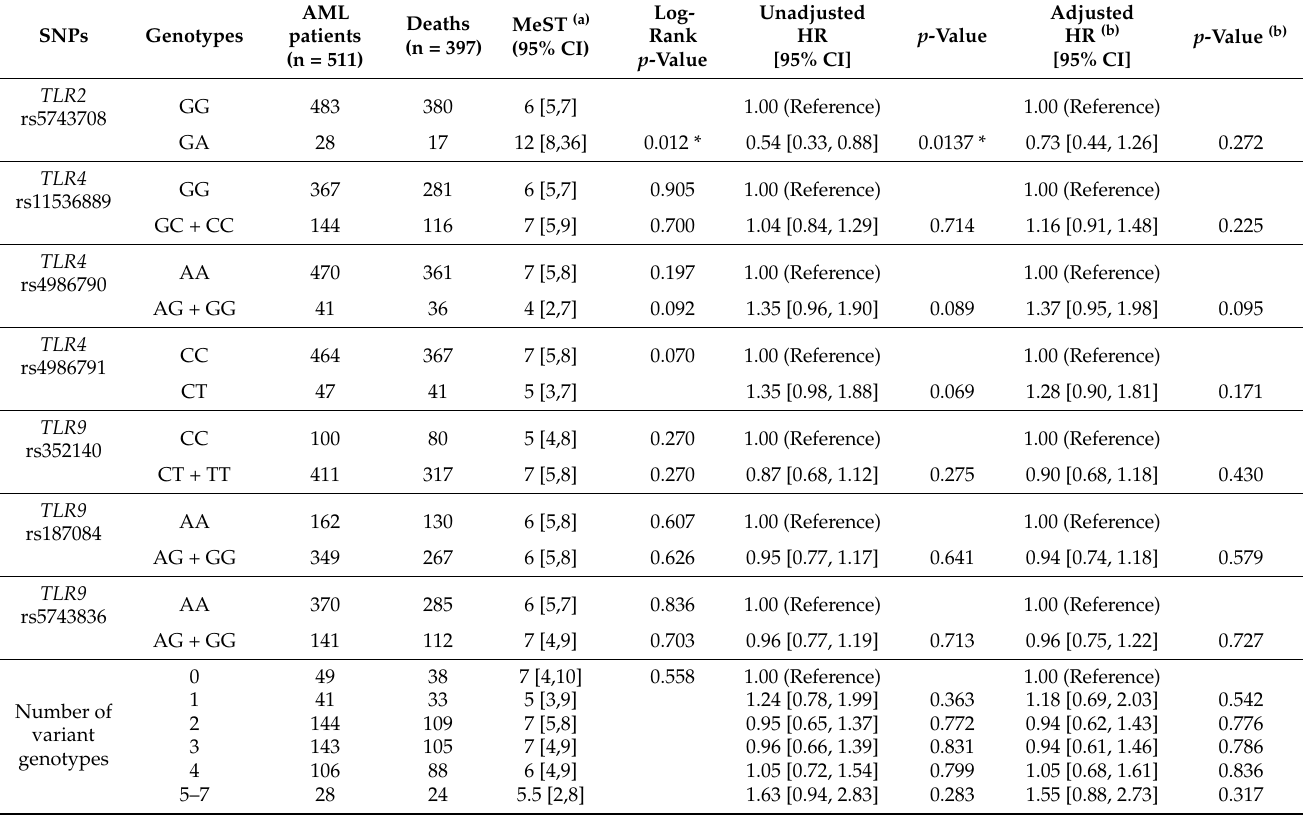
Table 6. Associations between different genotypes of studied SNPs and AML patients’ overall